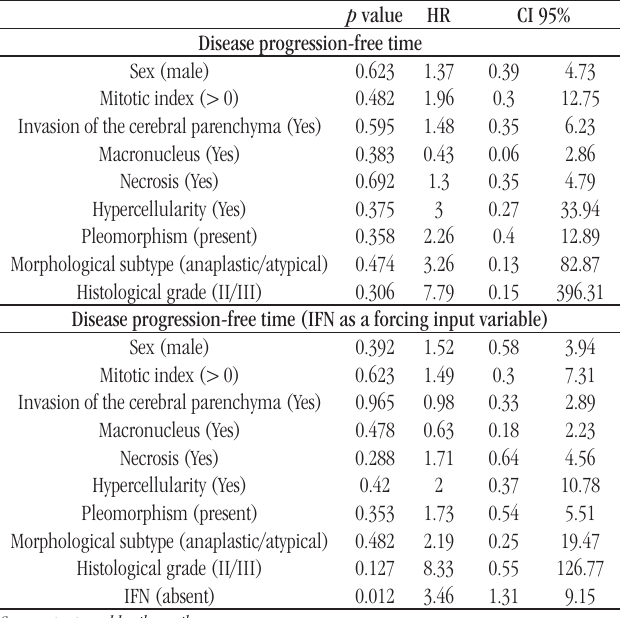
table 4 – Multivariate analysis of clinical and morphological